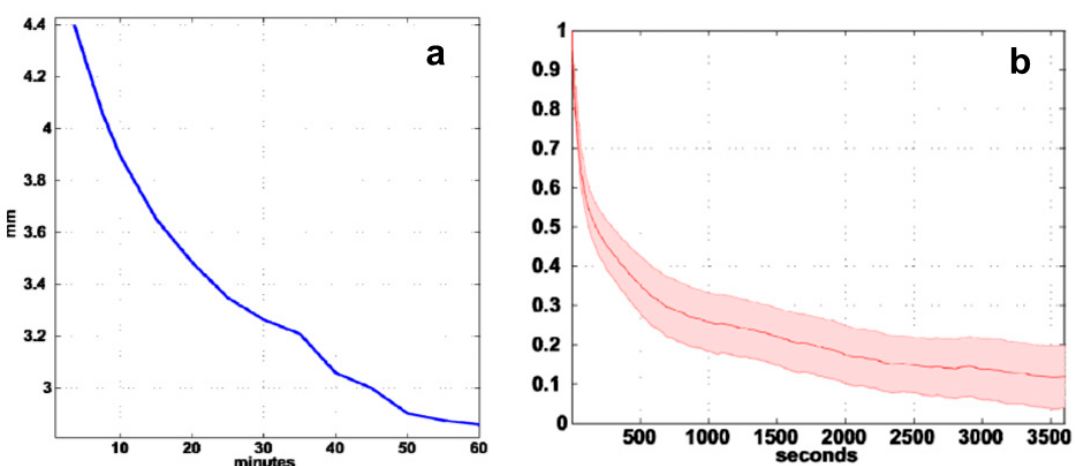
Figure 17. ( a ) Best windowing. In blue the mean (for all the stations and components) standard deviations, for di ff erent window sizes, of the estimated displacement time series from GPS solutions. ( b ) Mean autocorrelation function with shaded error bar for all the 1-Hz GPS time series. It is possible to see the steep decay of autocorrelation after lags of a few hundreds of seconds. Modified from